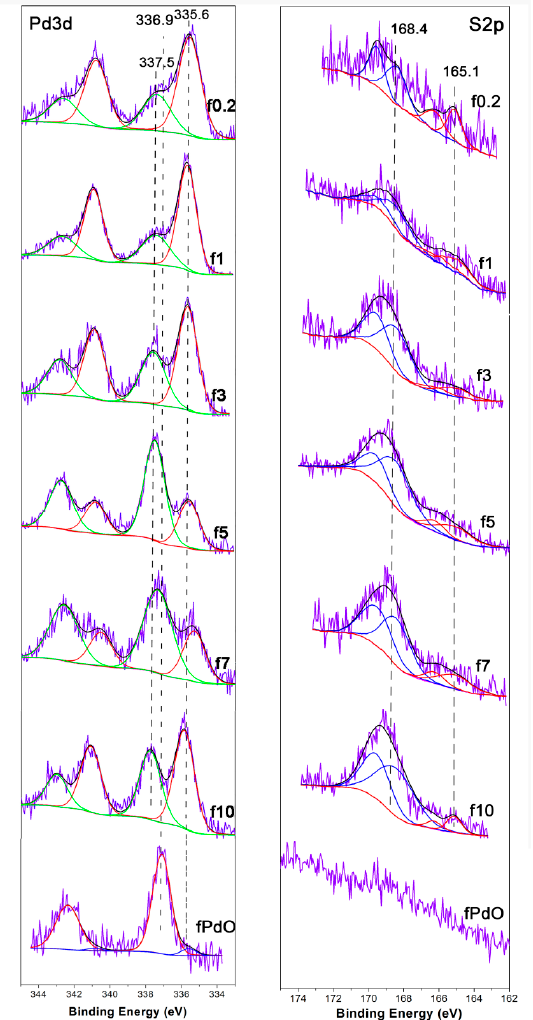
Figure 3. X-ray photoelectron spectroscopy (XPS) Pd3d and S2p of freshly prepared catalysts with different H 2 S concentration. Table 2. Palladium species content of freshly prepared catalysts with different H 2 S concentration. a. Catalyst